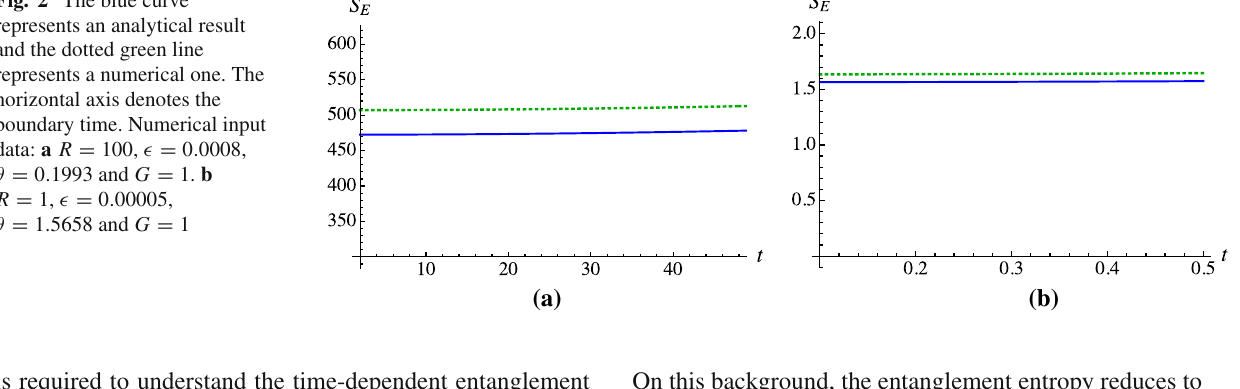
Fig. 2 The blue curve represents an analytical result and the dotted green line represents a numerical one. The horizontal axis denotes the boundary time. Numerical input data: a R = 100, (cid:9) = 0 . 0008, θ = 0 . 1993 and G = 1.